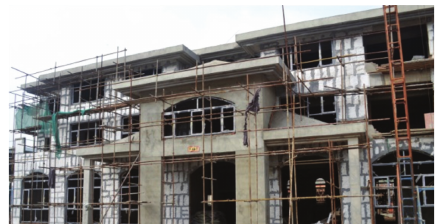
Figure 14: VIP at the fac¸ade of building.